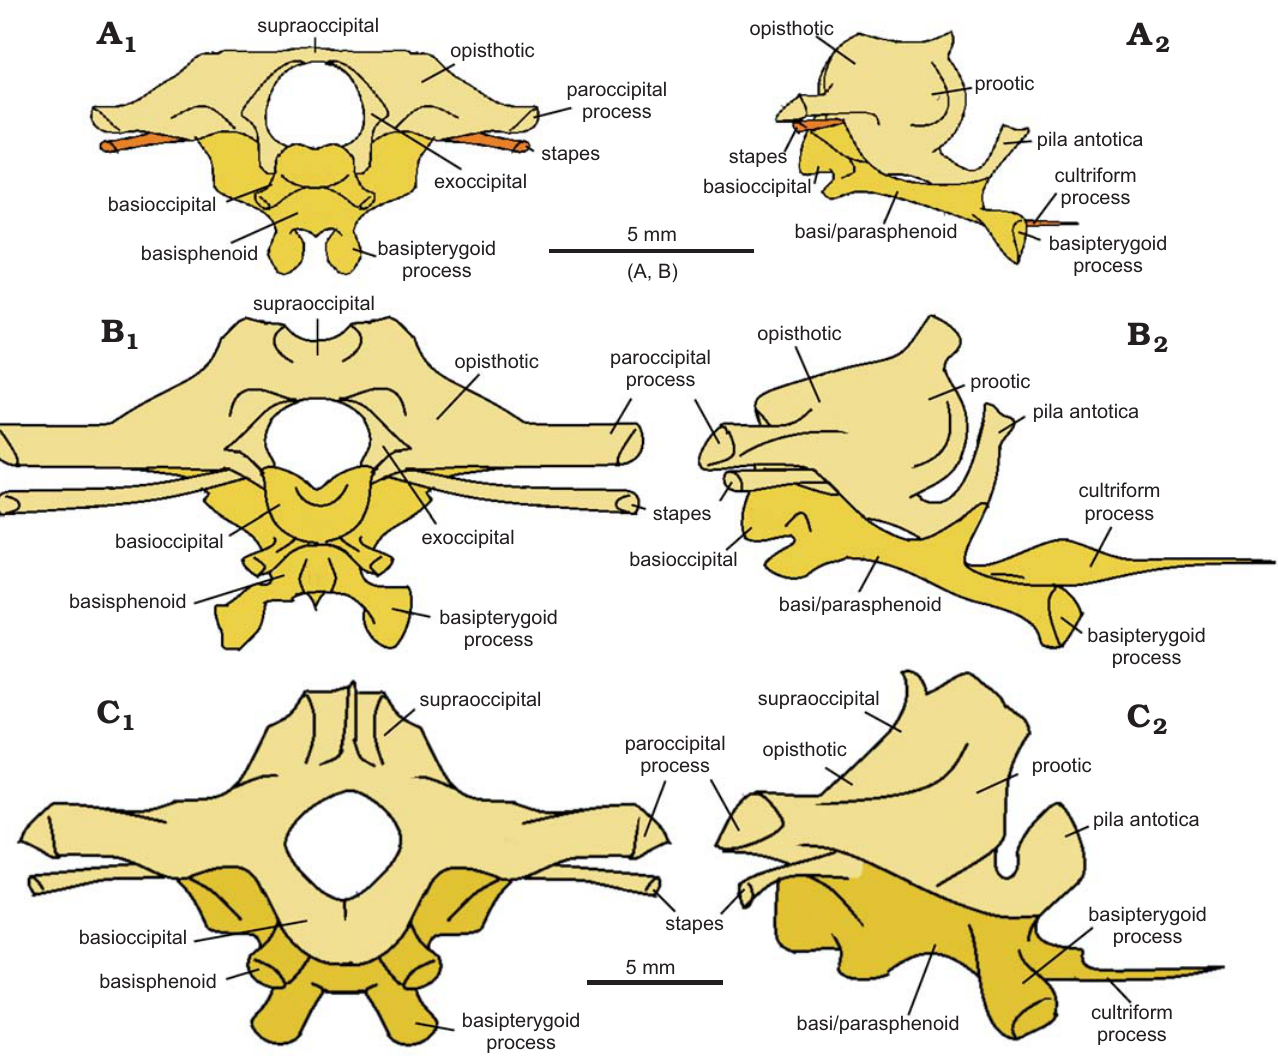
Fig. 14. The reconstructed braincases of lepidosaur rynchocephalians. A . Clevosaurus cambrica Keeble, Whiteside, and Benton, 2018. B . Clevosaurus hudsoni Swinton, 1939. C . Sphenodon punctatus (from Maisano 2001). In posterior (A 1 –C 1 ) and right lateral (A 2 –C 2 ) views. Bones types that are absent in their respective datasets are highlighted in